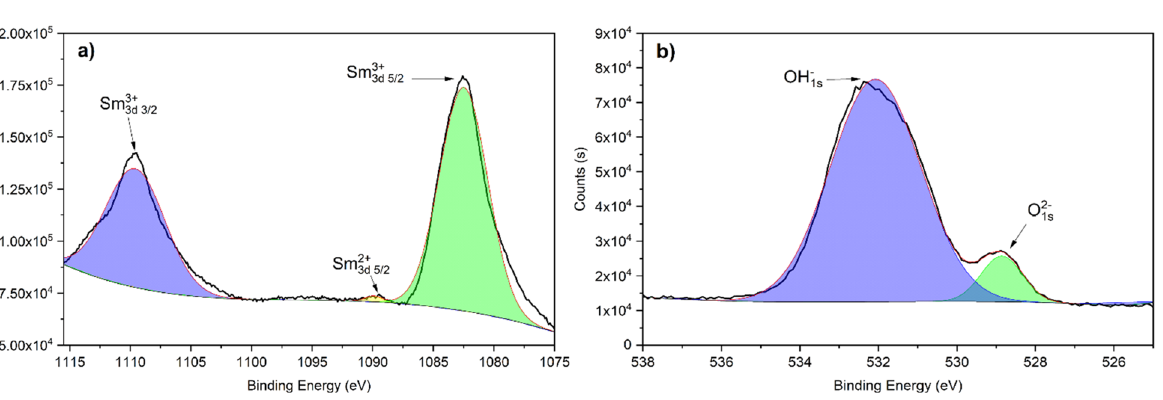
Figure 7. High-resolution XPS spectra of a samarium coating by APPJ corresponding to ( a ) Sm3d and ( b )